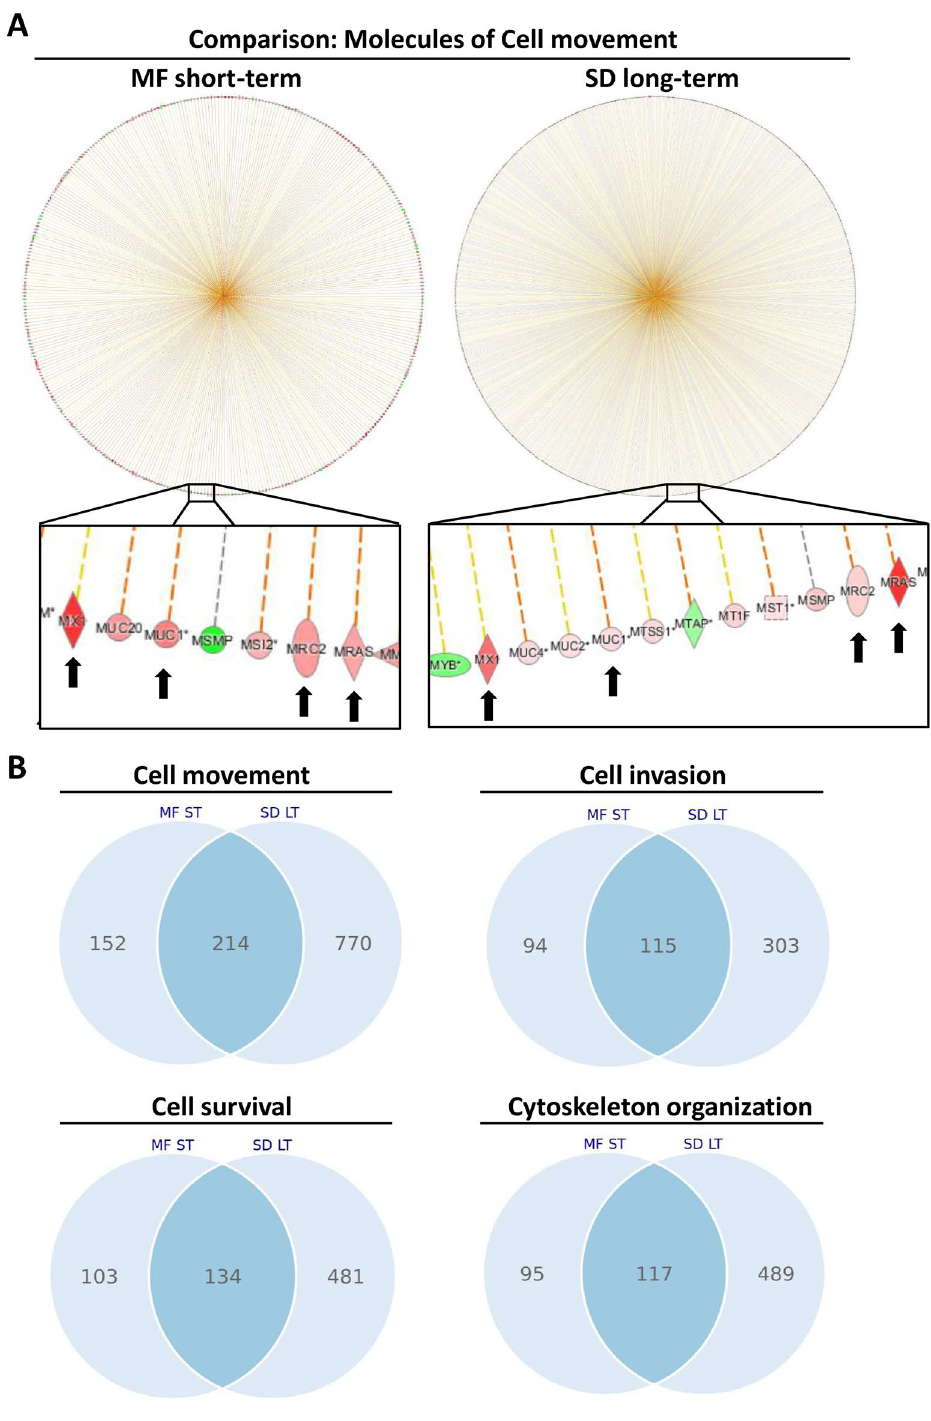
Figure 3. Irradiation activates pathway molecules contributing to cell movement, invasion, and survival. ( A ) Ingenuity Pathway Analysis (IPA) of genes involved in cell movement performed in PC3 cells at 24 h after a multifractionated regimen of 10 fractions of 1 Gy (MF-ST) or at 2 months after a single dose of 10 Gy (SD-LT). ( B ) Venn diagrams showing the number of overlapping or distinct significantly altered genes (fold change ≤ 0.66 or fold change ≥ 1.5, P < 0.05) involved in the indicated cell functions after a multifractionated regimen of 10 fractions of 1 Gy (MF-ST) or at 2 months after a single dose of 10 Gy (SD-LT). Gene expression has been normalized to the corresponding unirradiated